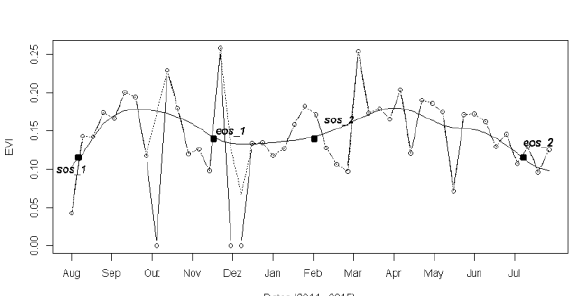
Figure 4. Time series EVI spectral profile for a semi-perennial crop sample of cassava.